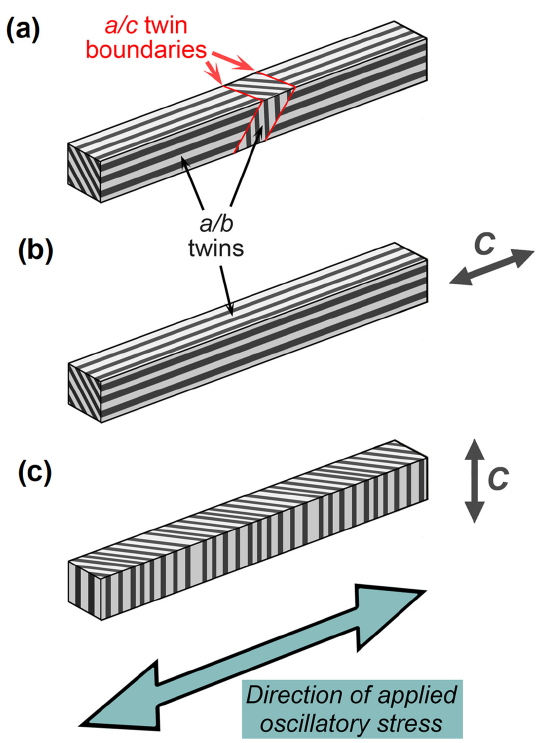
Figure 1. Schematic images of the a/c and a/b twin configurations in three types of the samples studied: ( a ) Structure 1 with two a/c twin boundaries, Type I and Type II, separating three martensitic variants; a/b twinning planes are parallel to the sample long axis in the two lateral variants and inclined 45° in the narrow central variant; ( b ) Structure 2 without a/c twin boundaries; c -axis and a/b twinning planes are parallel to the sample axis; ( c ) Structure 3 without a/c twin boundaries; c -axis is perpendicular to the sample axis and a/b twinning planes are inclined 45° with respect to the sample axis.